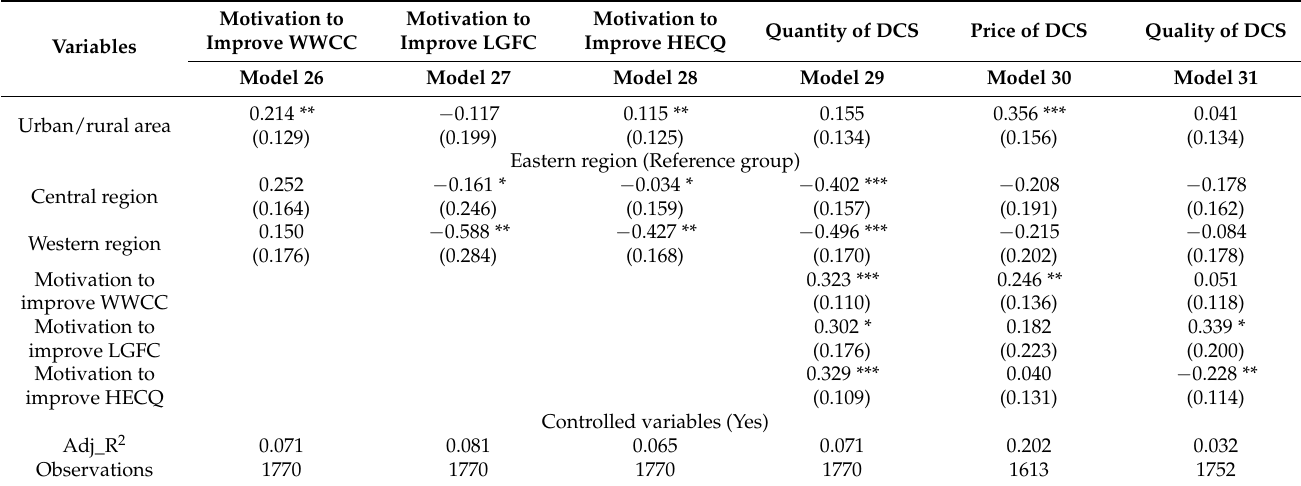
Table 6. The mediating effect of motivation to improve FCC.